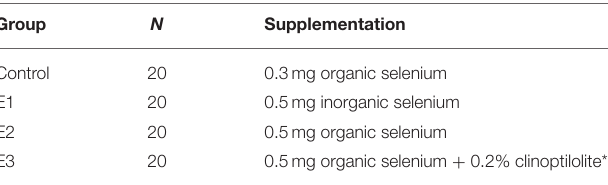
TABLE 2 | Selenium supplementation and experimental